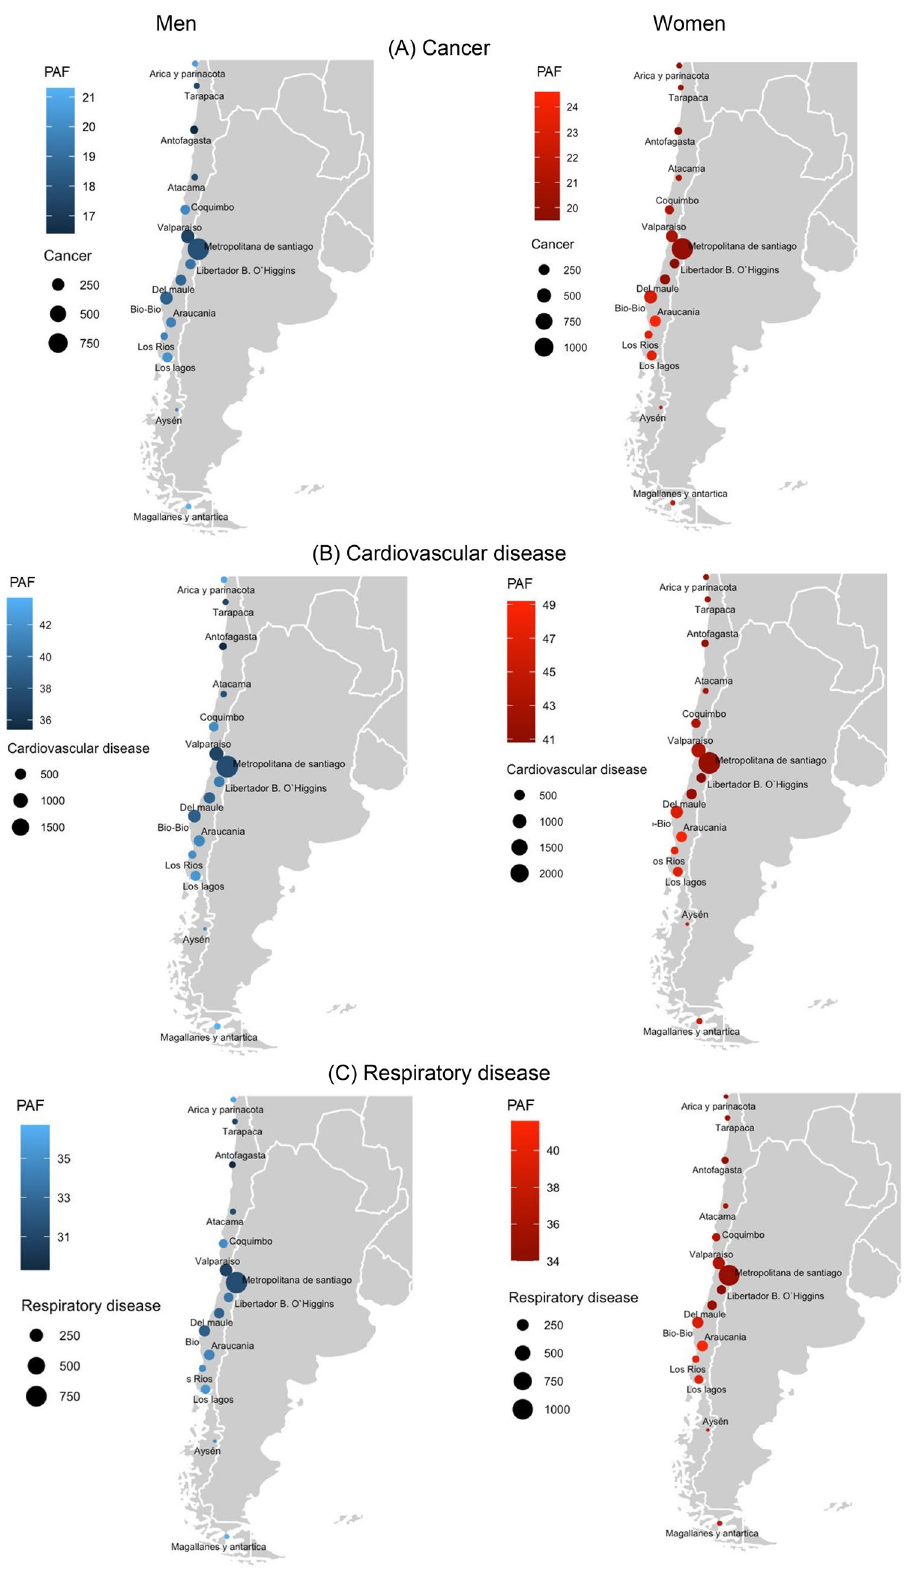
Figure 2. Population attributable fraction of ( A ) cancer; ( B ) cardiovascular disease; ( C ) respiratory disease; ( D ) major non- communicable disease; ( E ) all-cause mortality due to high body mass index in 15 Chilean geographical regions. Population attributable fraction indicate the proportion (%) of deaths attributable to cause-specific and all-causes of deaths. The size of the circle represents the absolute number of cause-specific and all-causes of deaths attributable to high body mass index. Figure was created from the R software (version 4.0.5: Copyright (C) 2020 The R Foundation for Statistical Computing Platform: x86_64-w64-mingw32/x64 (64-bit) Link: https:// www.r- proje ct.